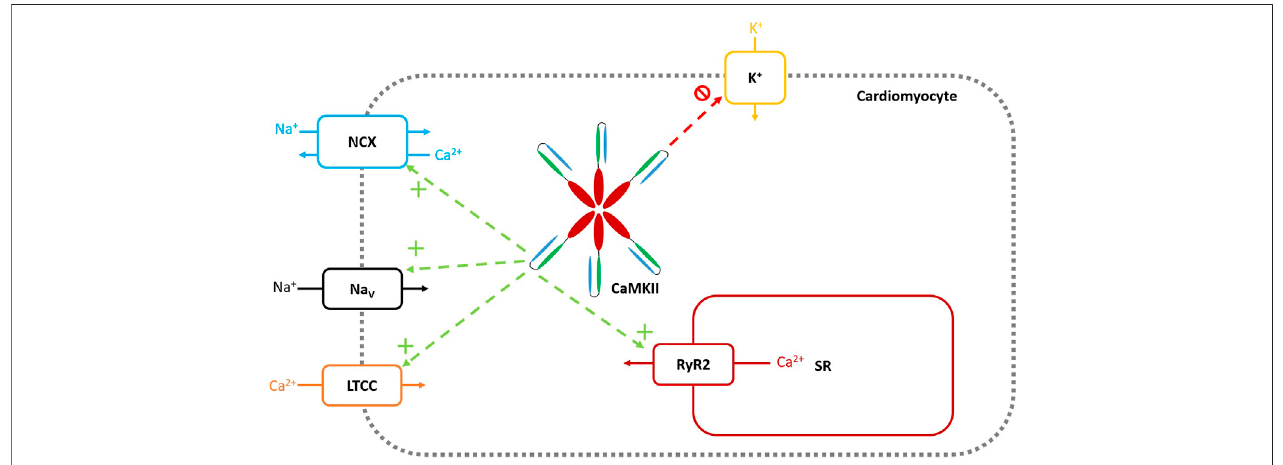
FIGURE 3 | Molecular Targets of CaMKII. Green arrows and + symbols represent CaMKII increasing functional activity of the target channel through either upregulation of channel numbers, or direct augmentation of channel activity. Red arrows and symbols represent CaMKII decreasing functional activity of the target channel. Veitch 2021, original